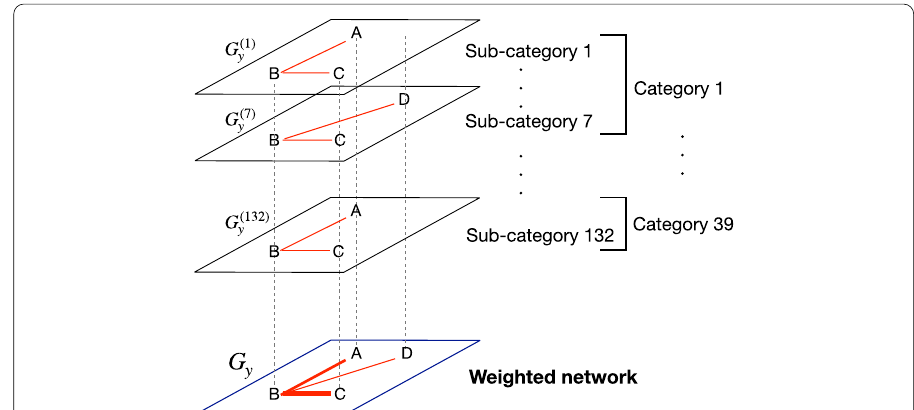
Fig. 1 Schematic image of the construction the co-occurrence network G y . The figure was adapted from Ref. (Ito and Ohnishi